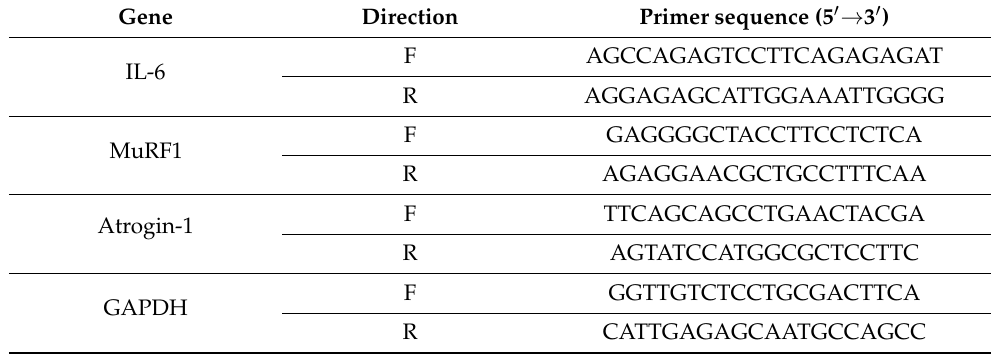
Table 1. Cont. Gene